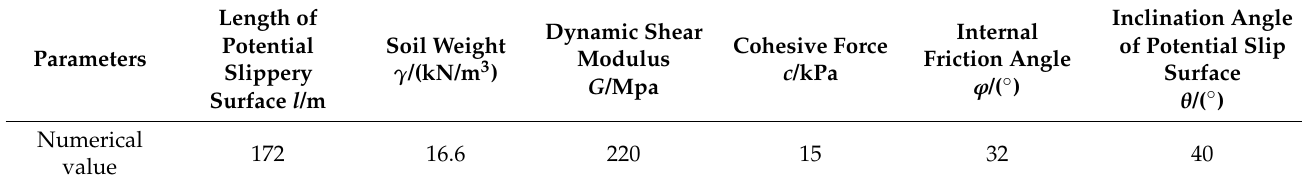
Figure 10. Influence of cohesive force of soil c on critical acceleration a c. Table 3. The geometry, physical and mechanical parameters of